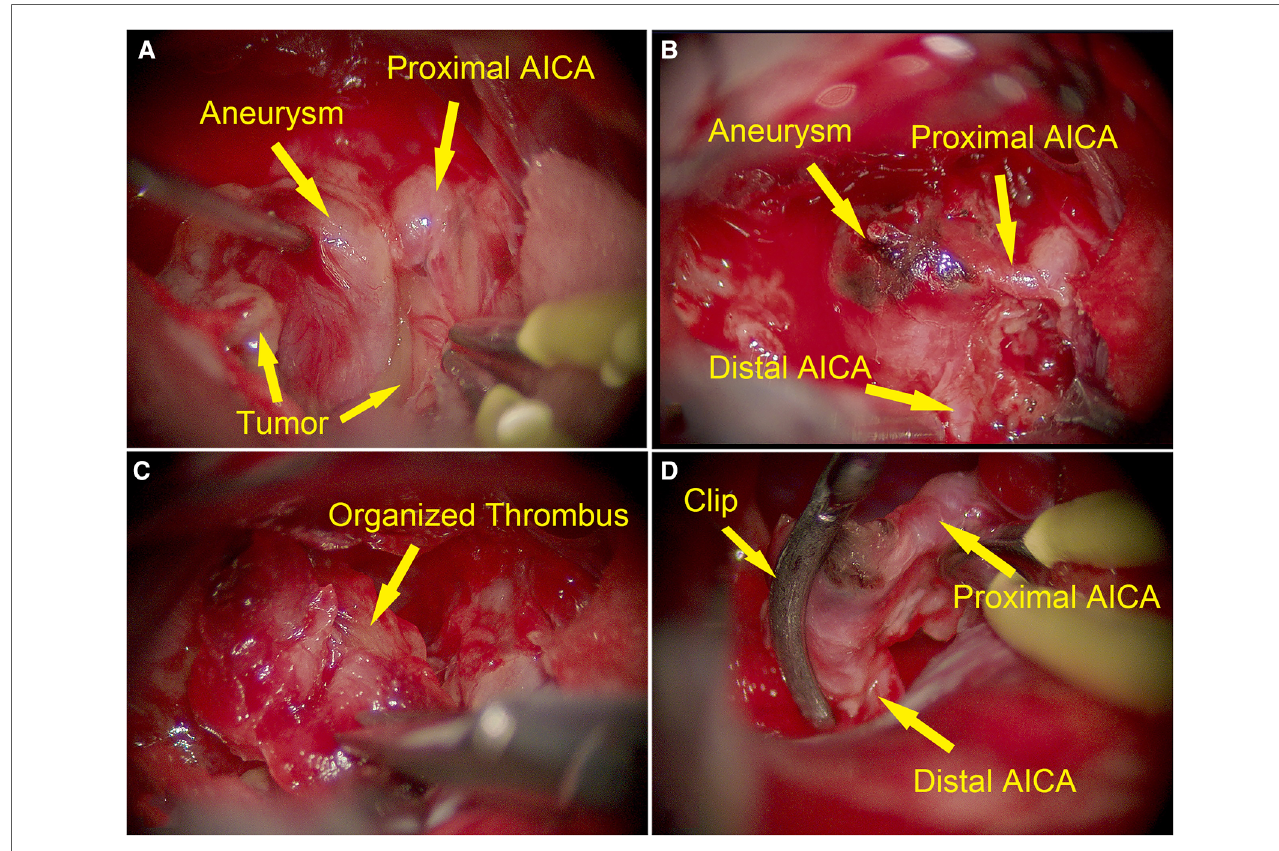
FIGURE 2 Intraoperative images of dissecting aneurysm arising from the main trunk of AICA (yellow arrows). ( A ) Intraoperative image showing a fusiform-like aneurysm with smooth adventitia embedded in the schwannoma. ( B ) The aneurysm arose from the main trunk of AICA. ( C ) The components of the aneurysm were identi fi ed as organized thrombus after incising the wall of the aneurysm. ( D ) AICA was preserved with